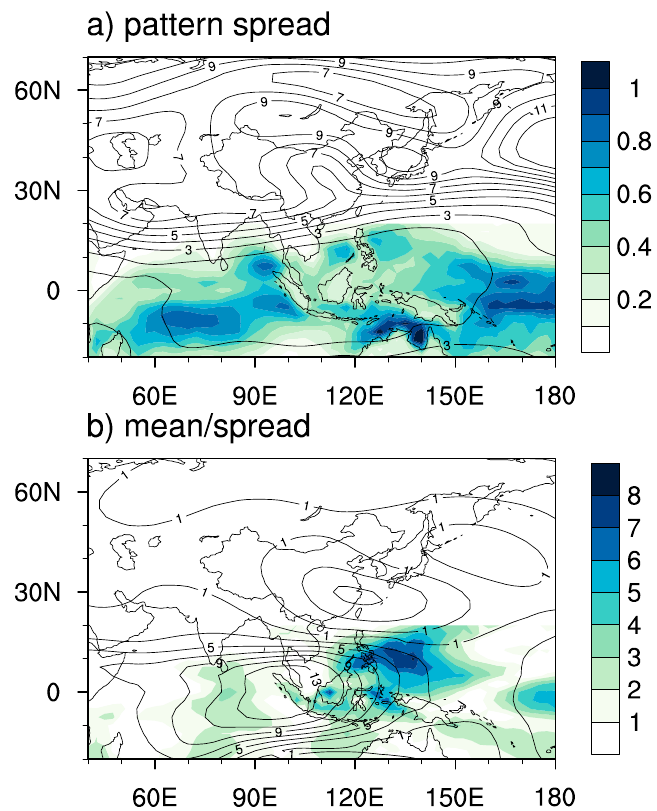
Figure 5. ( a ) Spread (standard deviation) of rainfall dipole (shading) and IWP–EA pattern (contours) across the 30 ensemble members. ( b ) Signal-to-noise ratio between ensemble mean and spread for rainfall dipole (shading) and IWP–EA pattern (contours).